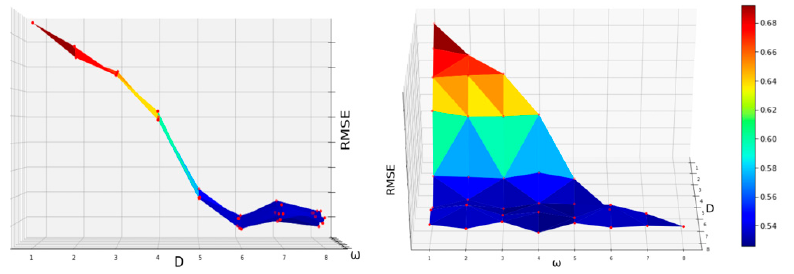
Figure 23. RMSE according to D and ω .